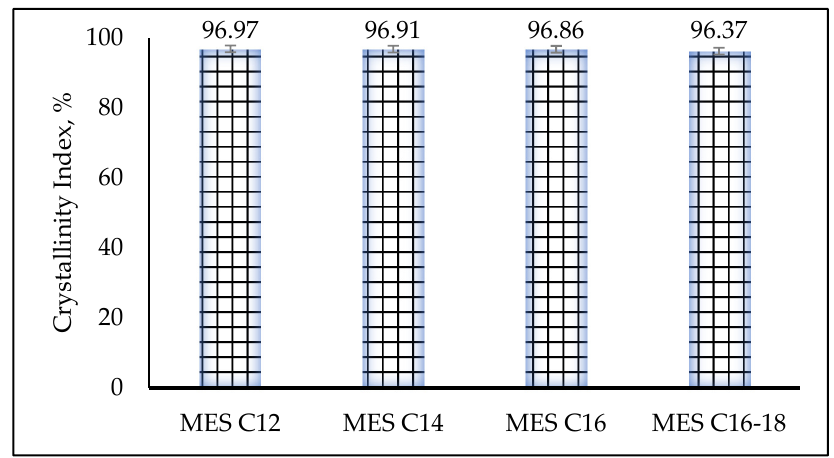
Figure 9. Crystallinity Index (CrI) of MES after repeated crystallization.